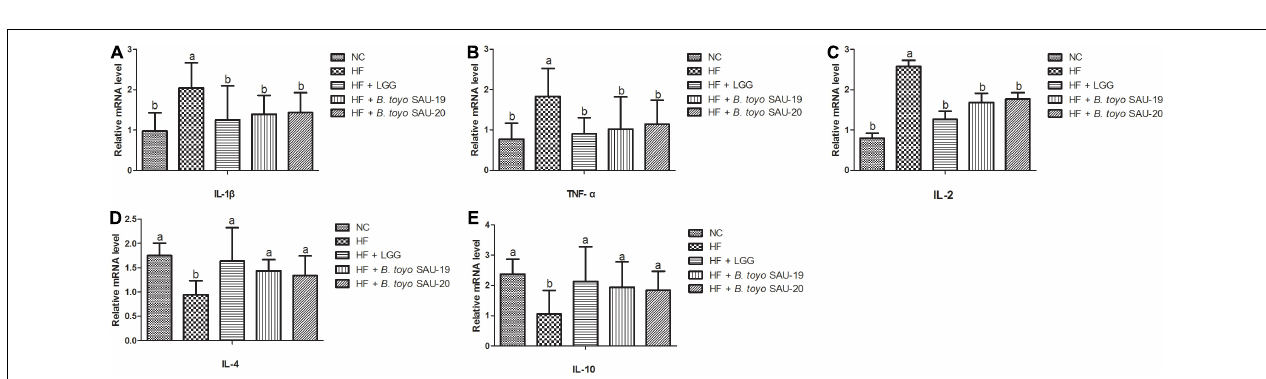
FIGURE 5 | Effects of Bacillus toyonensis SAU-19 and SAU-20 on tight junction proteins of the small intestine tissue in mice fed high fat diet. (A) Immunohistochemistry staining photographs of intestinal sections (yellow area represents occludin). (B) Immunohistochemical analyses of occludin levels in small intestine of mice in each group Bars represent means ± standard deviation (SD), the values are presented as the mean ± SD. Bars without the same letter differed significantly ( n = 4, P < 0.05). (C) mRNA expression of occludin in small intestine tissues (D) mRNA expression of ZO-1 in small intestine tissues. Bars represent means ± standard deviation (SD) for eight mice per treatment. The values are presented as the mean ± SD. Bars without the same letter differed significantly ( p < 0.05). NC, mice were administered normal diet + normal saline; HF, mice were fed high fat diet + normal saline; HF + LGG, mice were administered high fat diet + 10 6 Lactobacillus rhamnosus GG; HF + B. toyo. SAU-19, mice were administered high fat diet + 10 6 Bacillus toyonensis SAU-19 from A. adenophora ; HF + B. toyo. SAU-20, mice were administrated with high fat diet + 10 6 Bacillus toyonensis SAU-20 from A. adenophora .